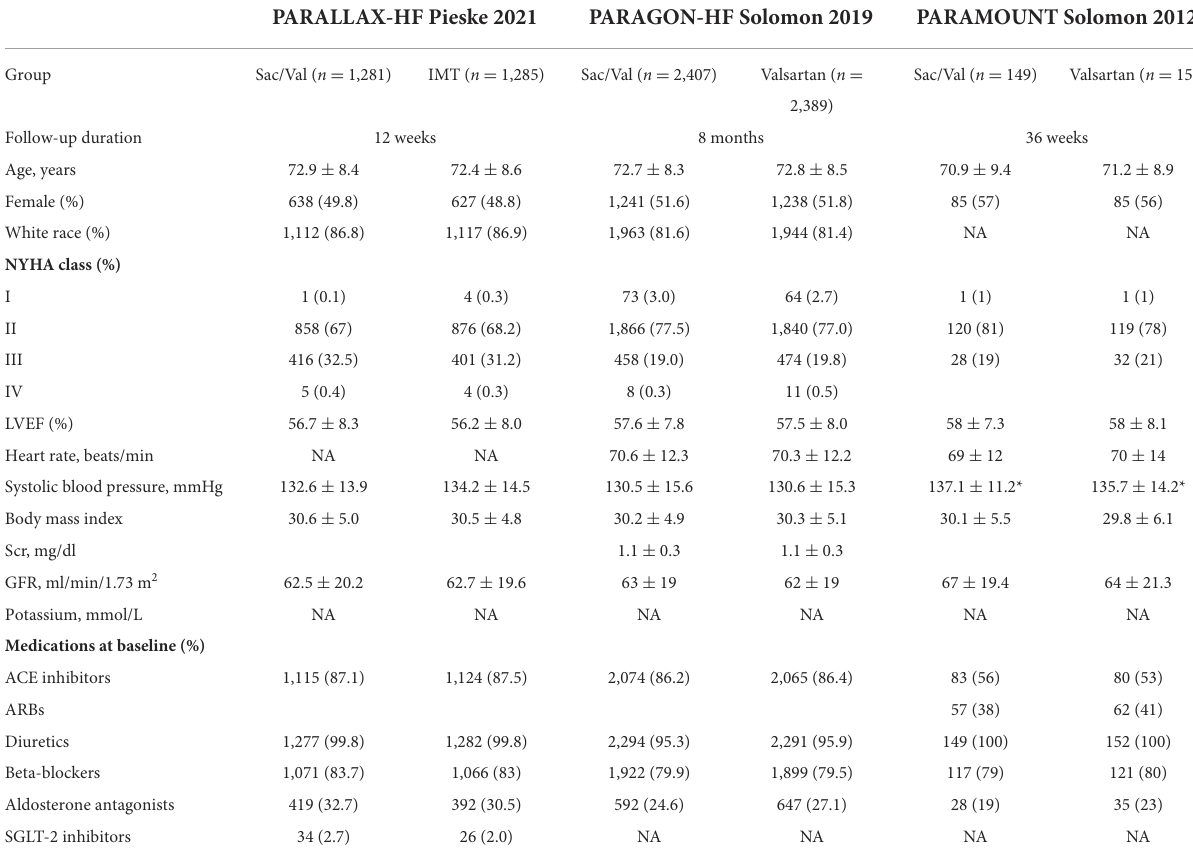
TABLE 2 Baseline characteristics of